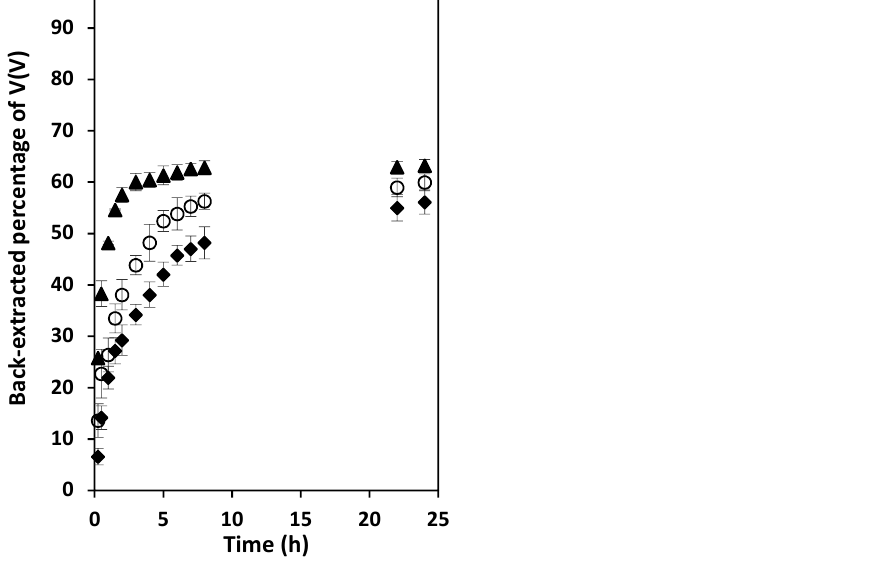
Figure 6. Back-extraction percentage of V(V) from loaded PIMs (50 wt% PVDF-HFP, 40 wt% Aliquat ® 336 and 10 wt% DBP; 33.5 mg V(V)/g PIM) in solutions containing 1.0 ( ), 3.0 ( ○ ) or 6.0 ( ▲ ) mol L −1 sulfuric acid under shaking as a function of time. PIMs/aqueous back-extraction solution contact time and temperature were 24 h and 22 ± 1 °C, respectively. Error bars = ± SD.